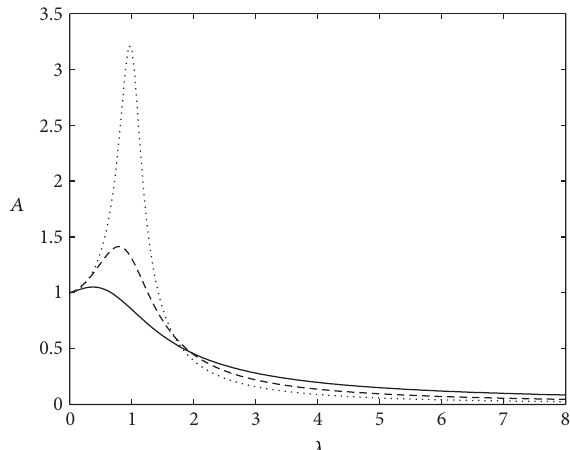
Figure 6: Curves of 𝐴 versus 𝜆 for 𝑏 = 1 and 𝑐 = 1 and for 𝛼 = 1.2 (solid line), 𝛼 = 1.5 (dashed line), and 𝛼 = 1.8 (doted line).